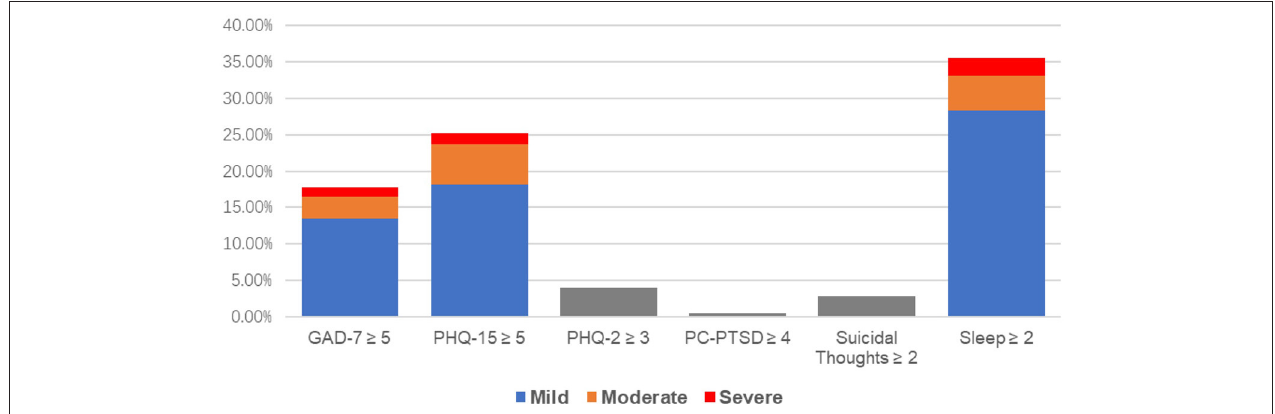
FIGURE 1 | Prevalence rates for symptomatic ratings. 1. For GAD-7 and PHQ-15 the cutting score is 5. 2. For PHQ-2 the cutting score is 3. 3. For PC-PTSD the cutting score is 4. 4. For Suicidal thoughts and Sleep, symptomatic means at least “more than half of the days” in the past 2 weeks. with the severity of suicidal thoughts (X² = 12.22, P <